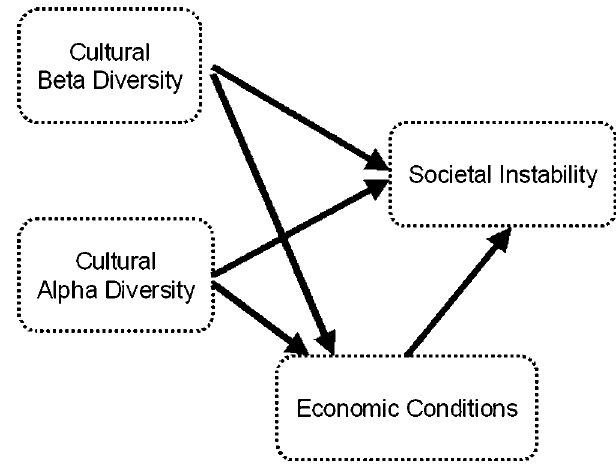
Figure 1. The conceptual structure of the a priori models examined. Not shown are the controlled effects of population size and the number of borders a nation possesses.